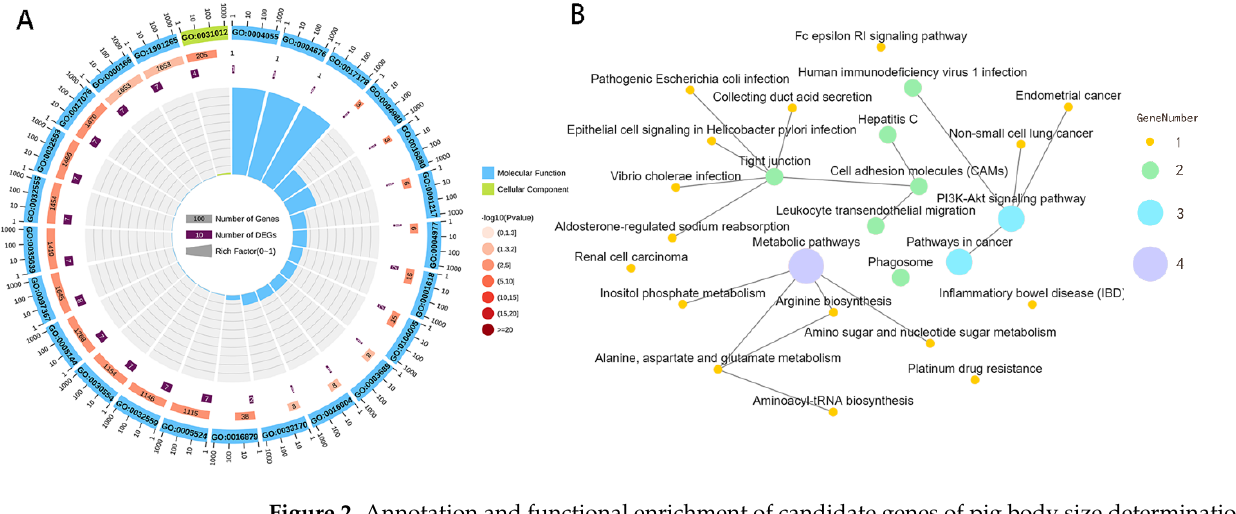
Figure 2. Annotation and functional enrichment of candidate genes of pig body size determination. Note: ( A ) Circle graphic of gene ontology (GO) enrichment. ( B ) Network graphic pattern of top 25 significant enriched molecular signaling pathways (KEGG).